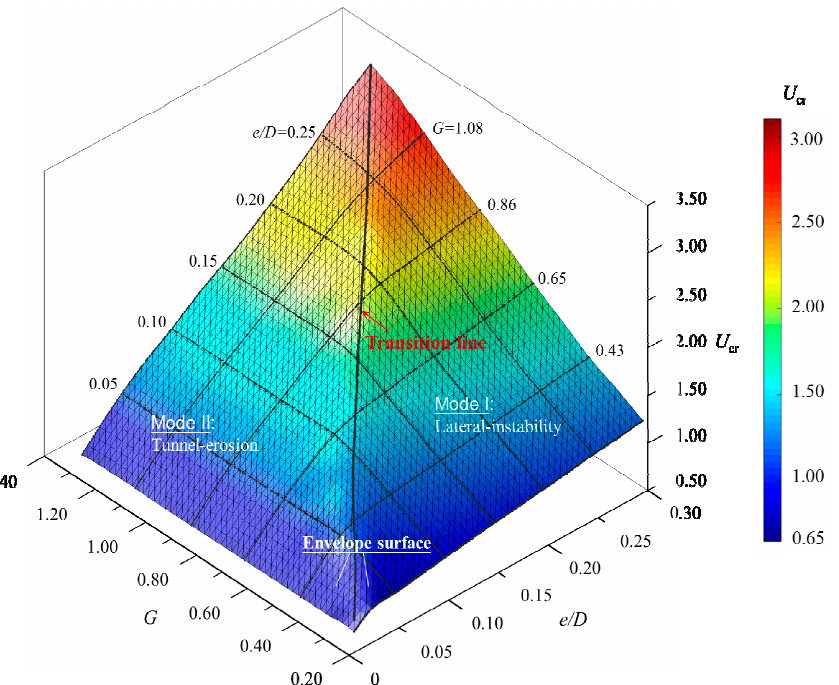
Figure 14. Instability envelope for the flow–pipe–soil interaction: variations of U cr with e / D and G .